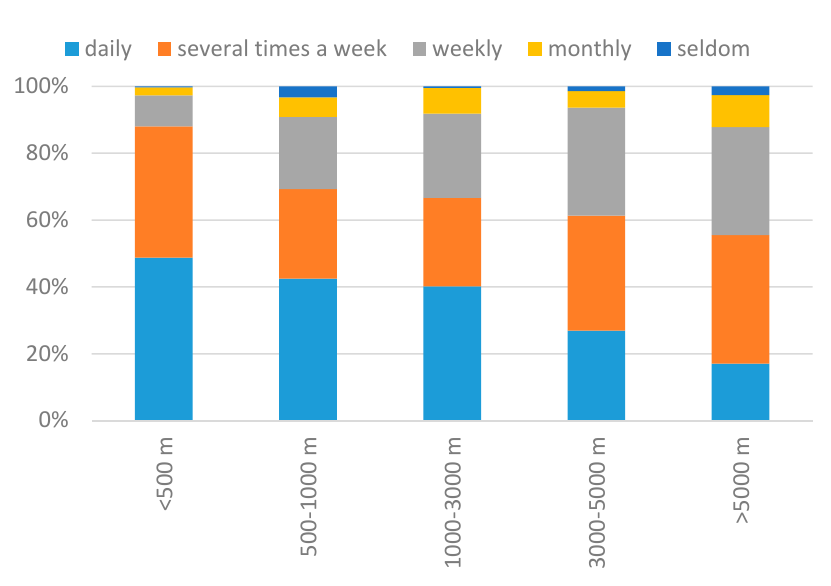
Figure 3. Distance to the Wutong Greenway vs. frequency of use, in percent of the respondents.